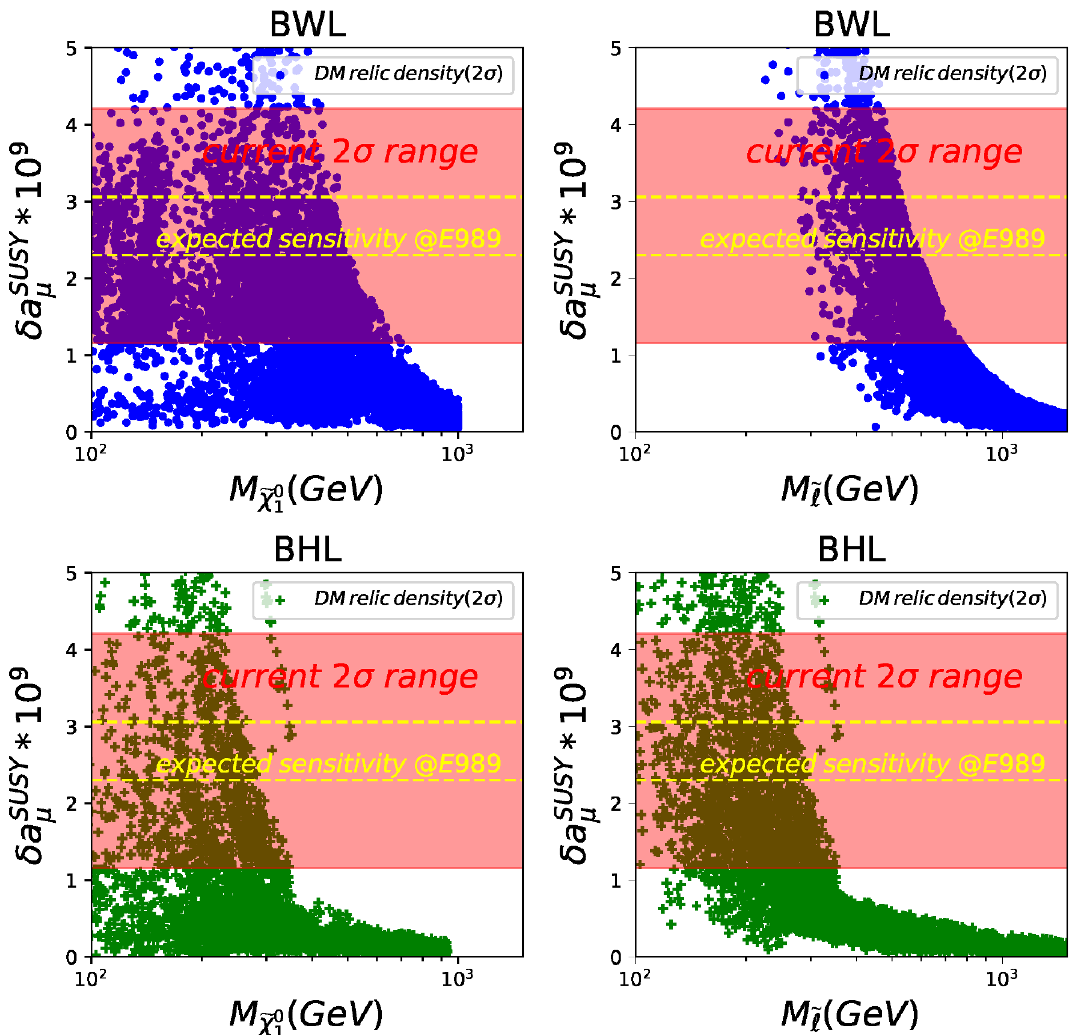
Figure 1 . Scatter plots of the two types of samples survived the constraints (1){(4) on the plane of (cid:14)a SUSY versus m and m ~ , showing the contributions to the muon g (cid:0) 2. The shaded areas are ~ (cid:31) 0 1 (cid:22) ‘ the current 2 (cid:27) ranges, while the regions between the dotted lines are the projected 2 (cid:27) sensitivity of the experiment at Fermilab (E989), where the expected central value is assumed same as the current experimental